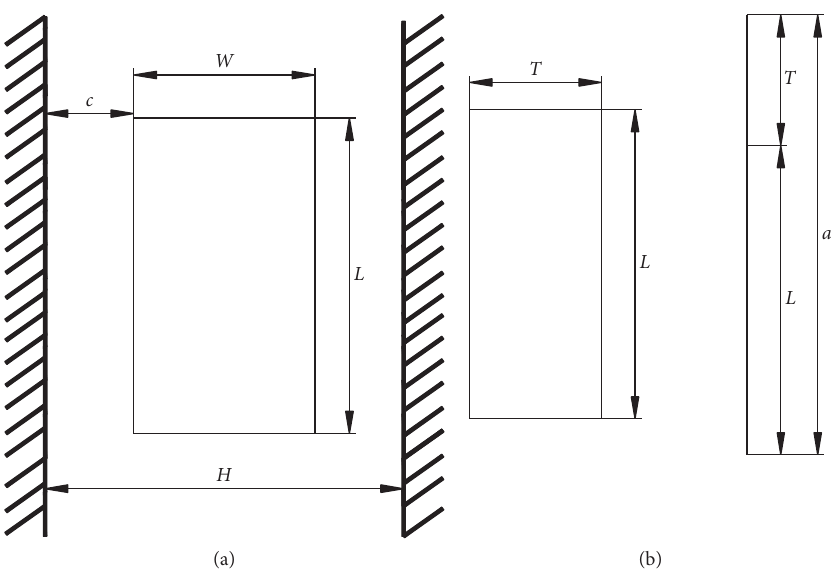
Figure 1: Translational clearance model. (a) Front view of the slider. (b) Side view of the slider.